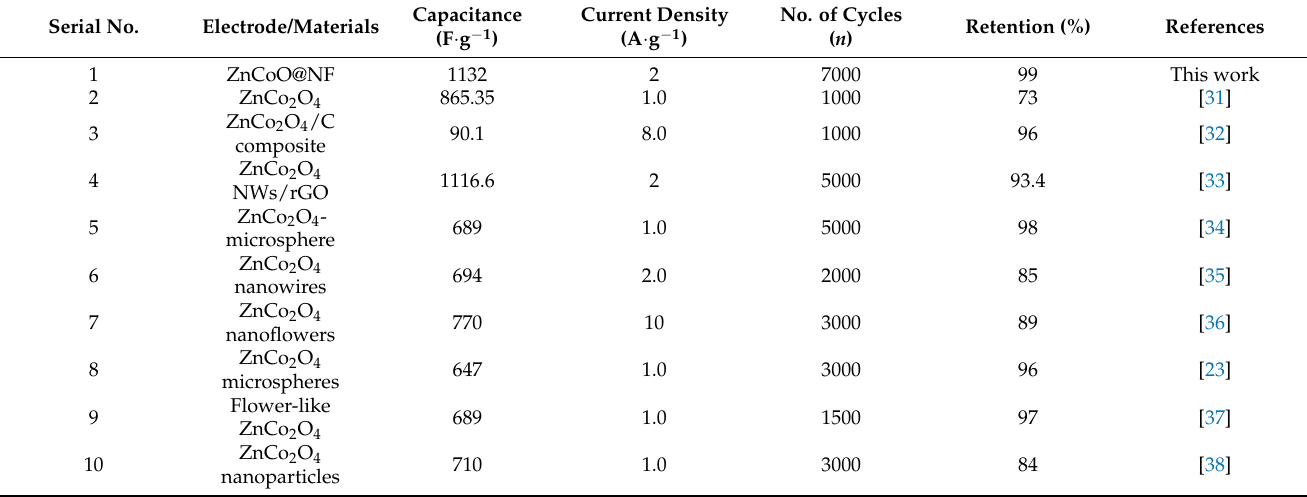
Table 1. Comparisons of the ZnCoO@NF electrode with previous literature in terms of electrode material, capacitance, current density, number of cycles, and